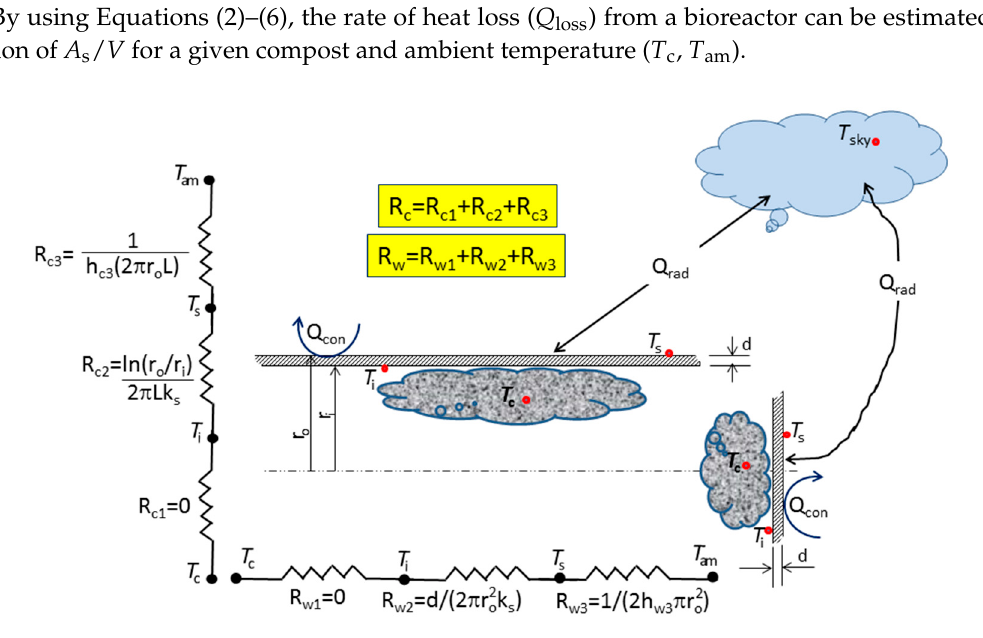
Figure 1. Schematic diagram showing thermal resistance against heat loss from compost–moist air mixture to outside ambient air through the cylindrical part and the vertical circular side walls.